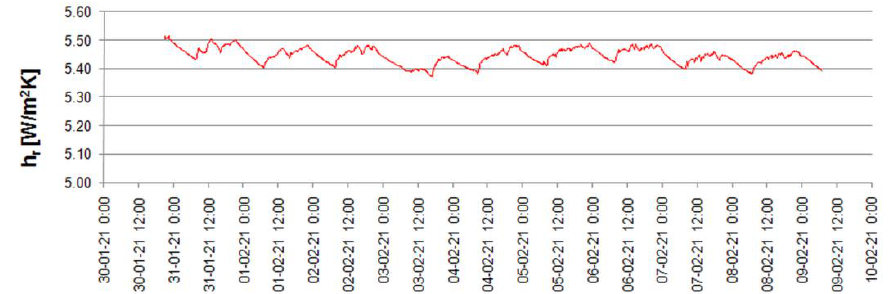
Figure 5. Radiative heat transfer coefficient from measurements.